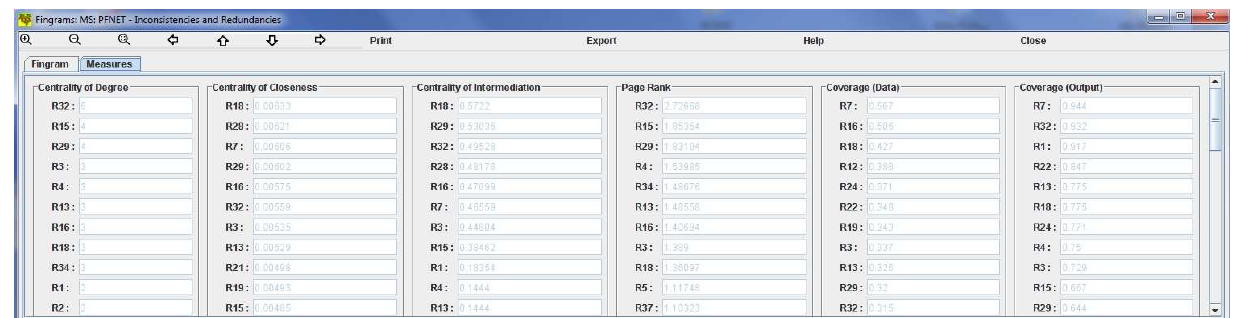
Figure 6: Fingram analysis